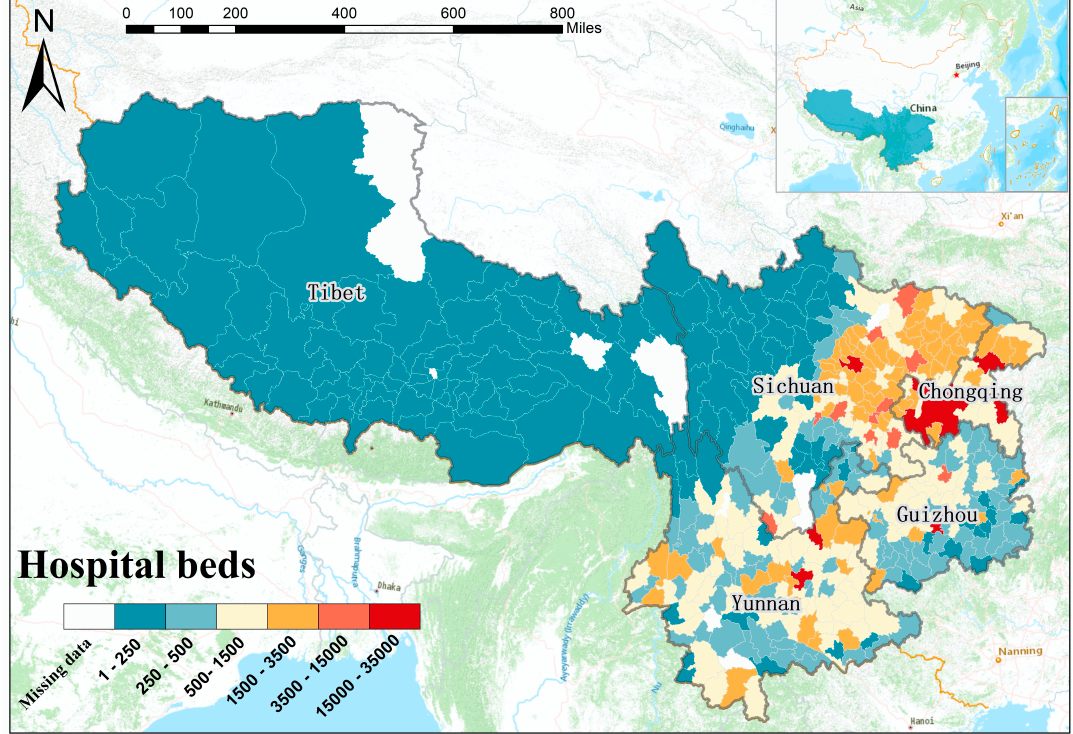
Figure 2 Figure 1. Geographical distribution of the original county-level hospital beds in the study area of